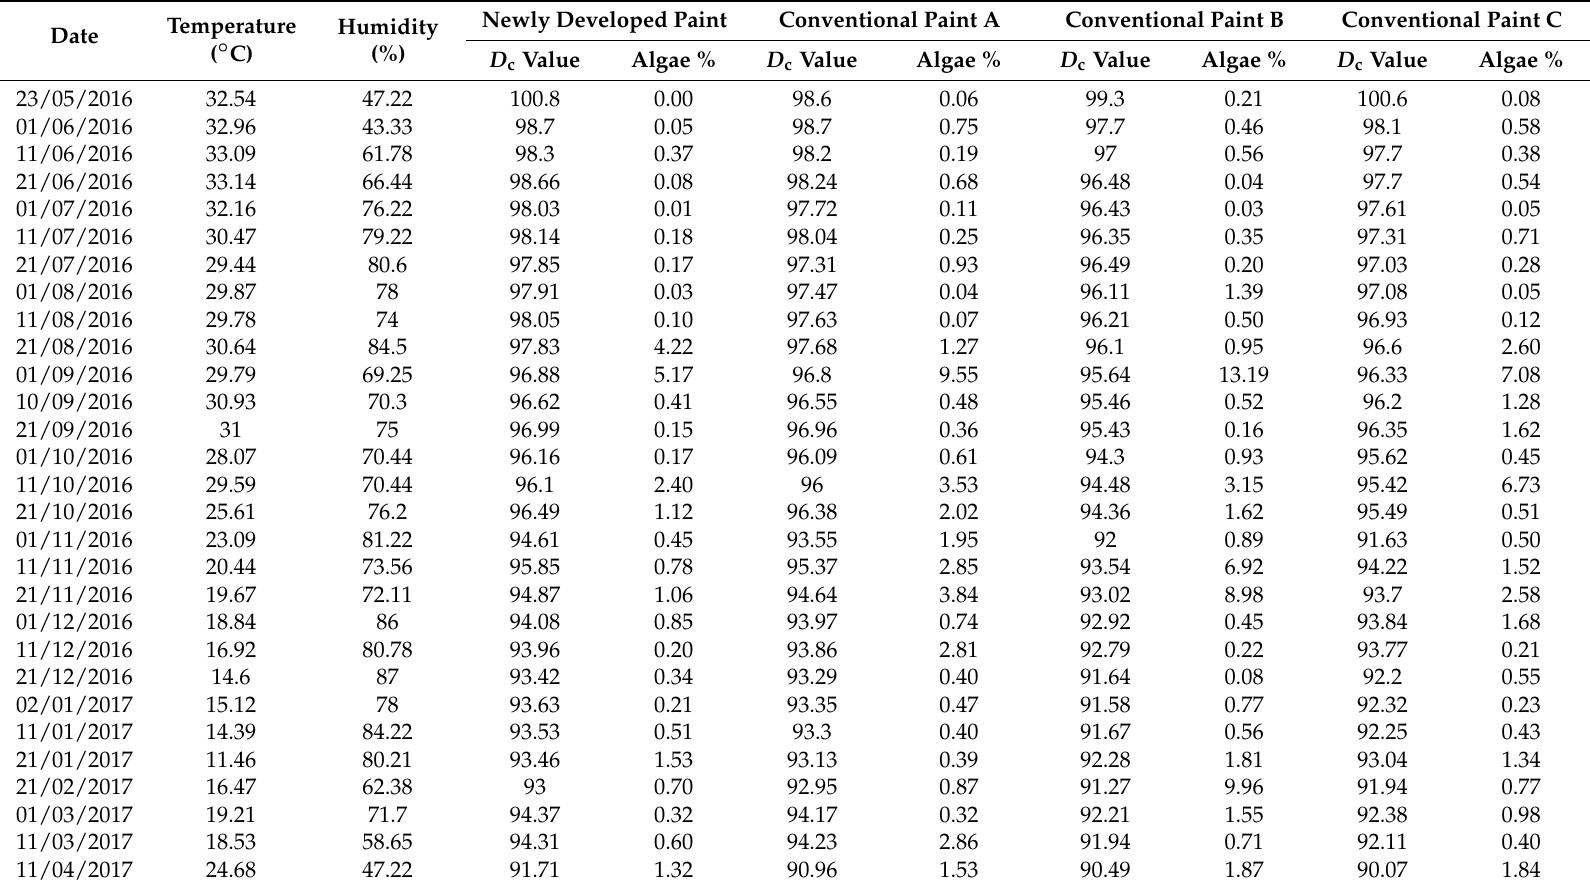
Table 3. Summary of experimental results of Algal